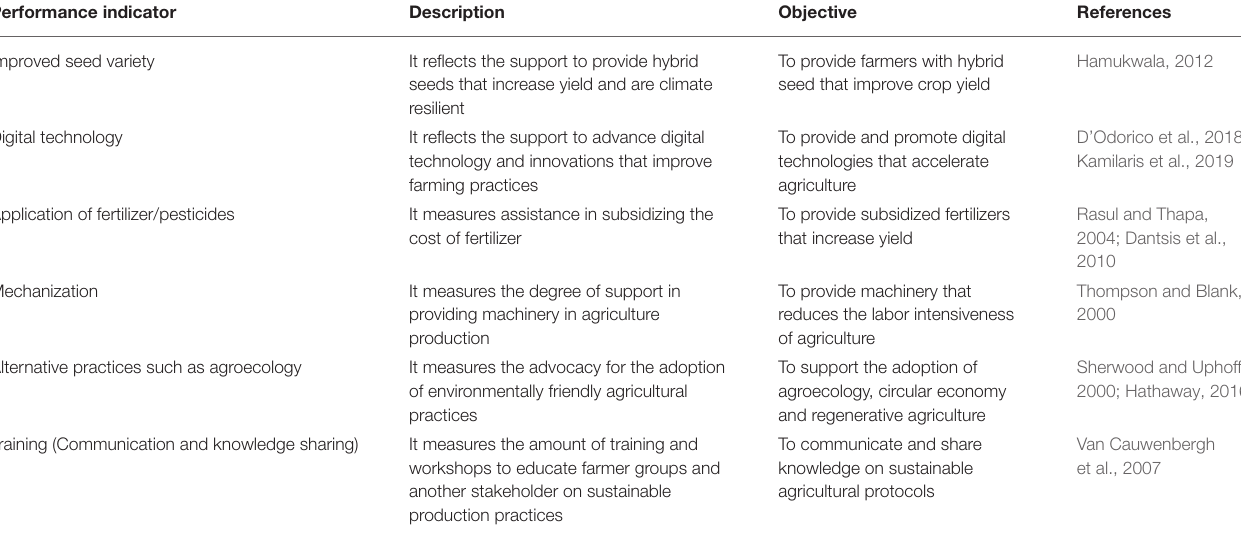
TABLE 2 | Indicators to measure support for food production.